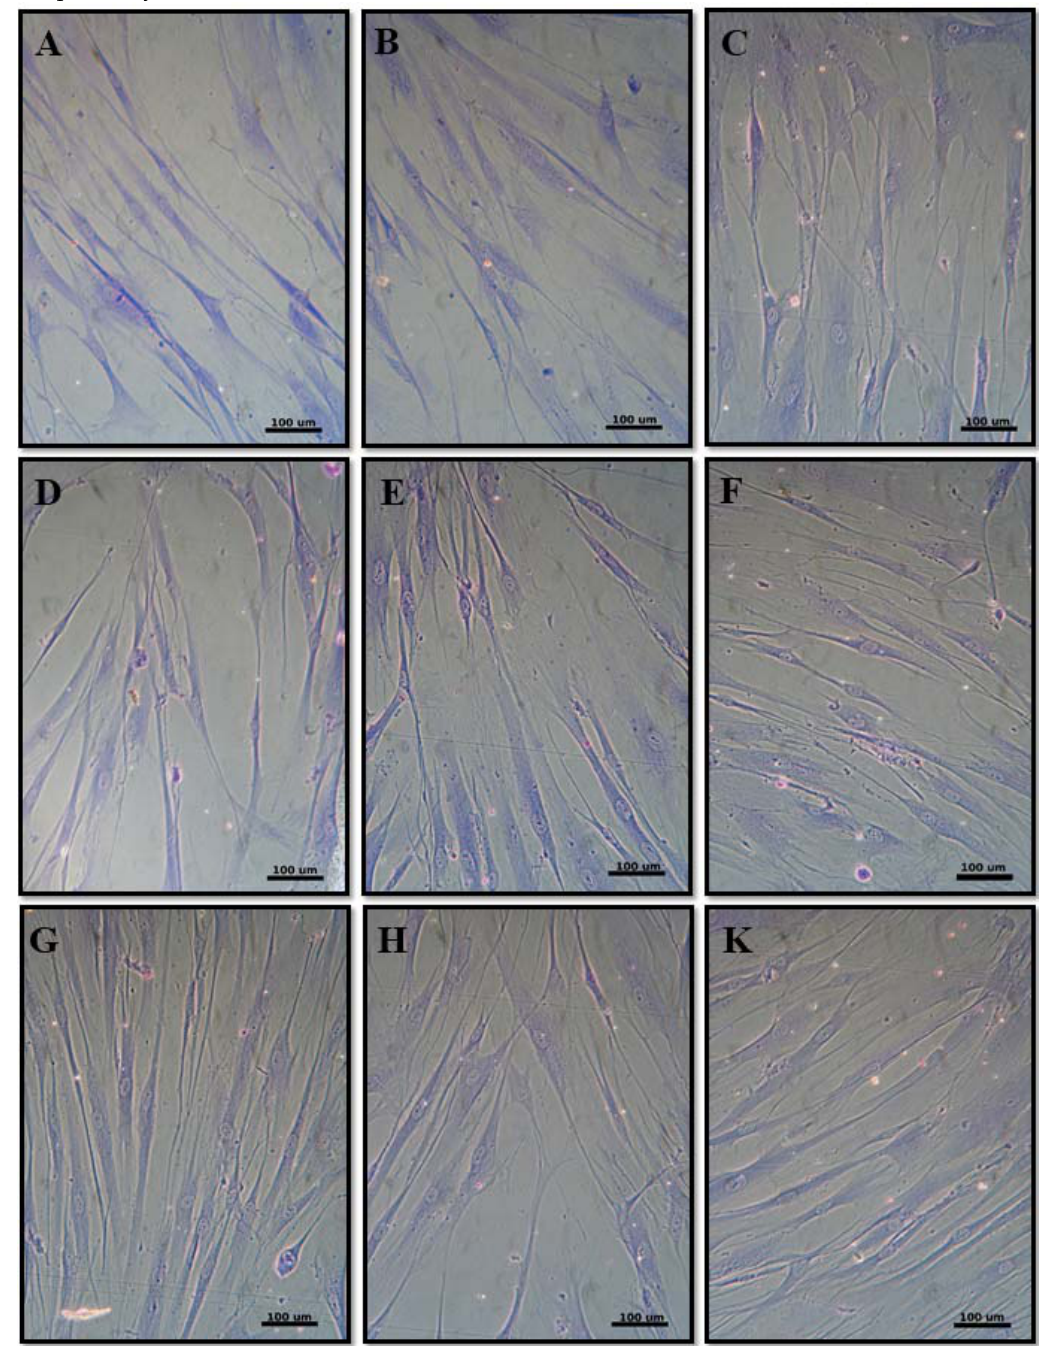
Figure 4. Cell morphology of negative control ( A ), T1A0Z99 ( B ), T10A0Z90 ( C ), T1A99Z0 ( D ), T10A90Z0 ( E ), T5A47Z47 ( F ), T2A24Z74 ( G ), T7A24Z69 ( H ), and T7A69Z24 ( K